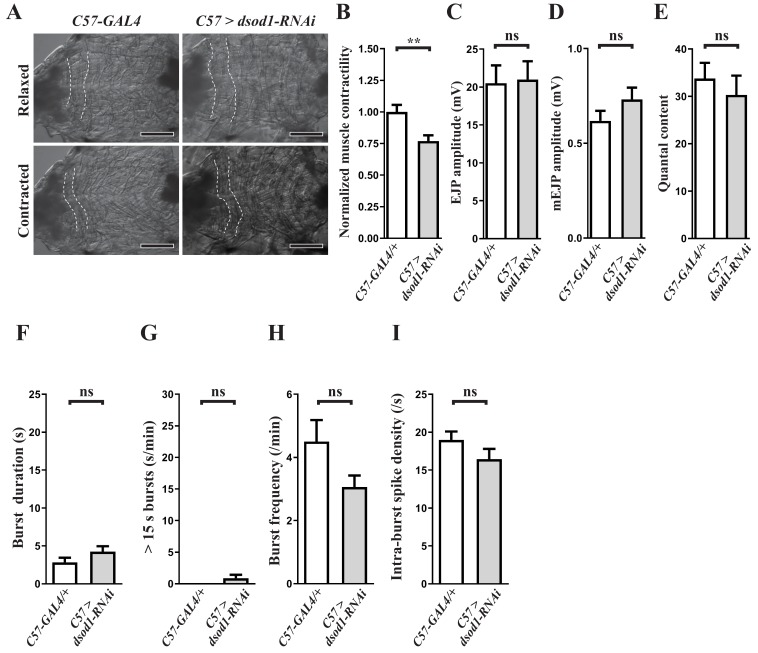
Phenotypic characterization of dsod1 knockdown larvae.(A–B) Expression of dsod1-RNAi in muscles using C57-GAL4 impairs muscle contractility. (A) Video snapshots of third instar larval fillets of indicated genotypes during fictive locomotion. A2 segmental muscles are outlined by dotted lines. Scale bars: 0.1 cm. (B) Overall muscle surface area in relaxed or contracted state during fictive locomotion. Reduced muscle surface area upon contraction is divided by the surface area of relaxed muscles to indicate muscle contractility (n ≥ 10 animals for each genotype). (C–I) Muscular knockdown of dsod1 does not affect neurotransmitter release and locomotor CPG output activity. P values: ns, no significance; **, p<0.01. n: replicate number. Error bars indicate SEM. Statistics: Student's t-test.10.7554/eLife.47372.028Figure 6—figure supplement 1—source data 1.Source data for Figure 6—figure supplement 1.